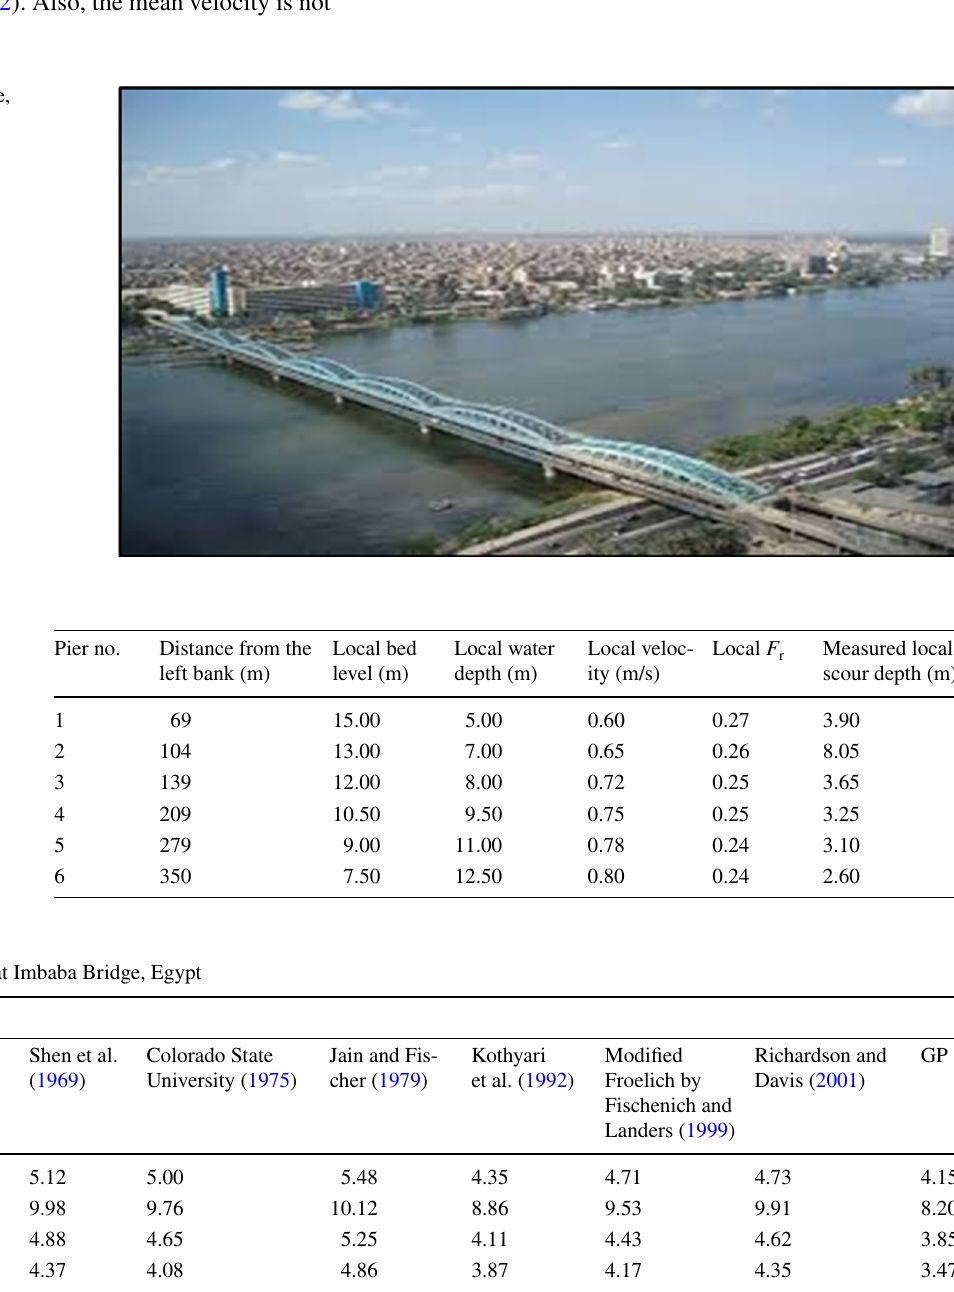
Fig. 12 View of Imbaba Bridge, Giza, Egypt